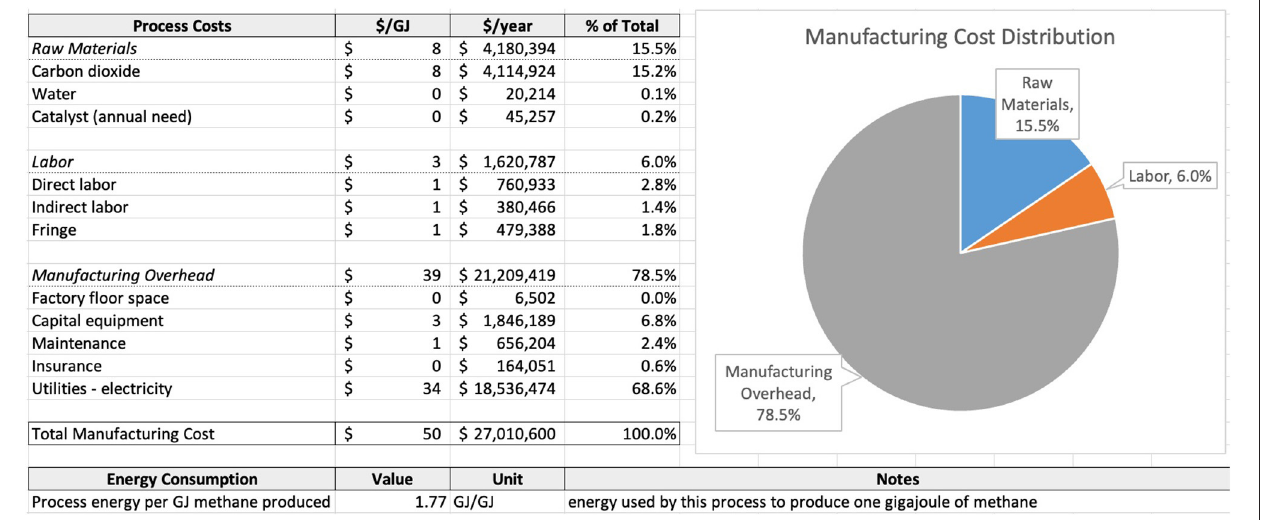
FIGURE 3 | Summary table and pie chart for TEA indicators showing distribution of raw material, labor, and manufacturing overhead costs along with energy